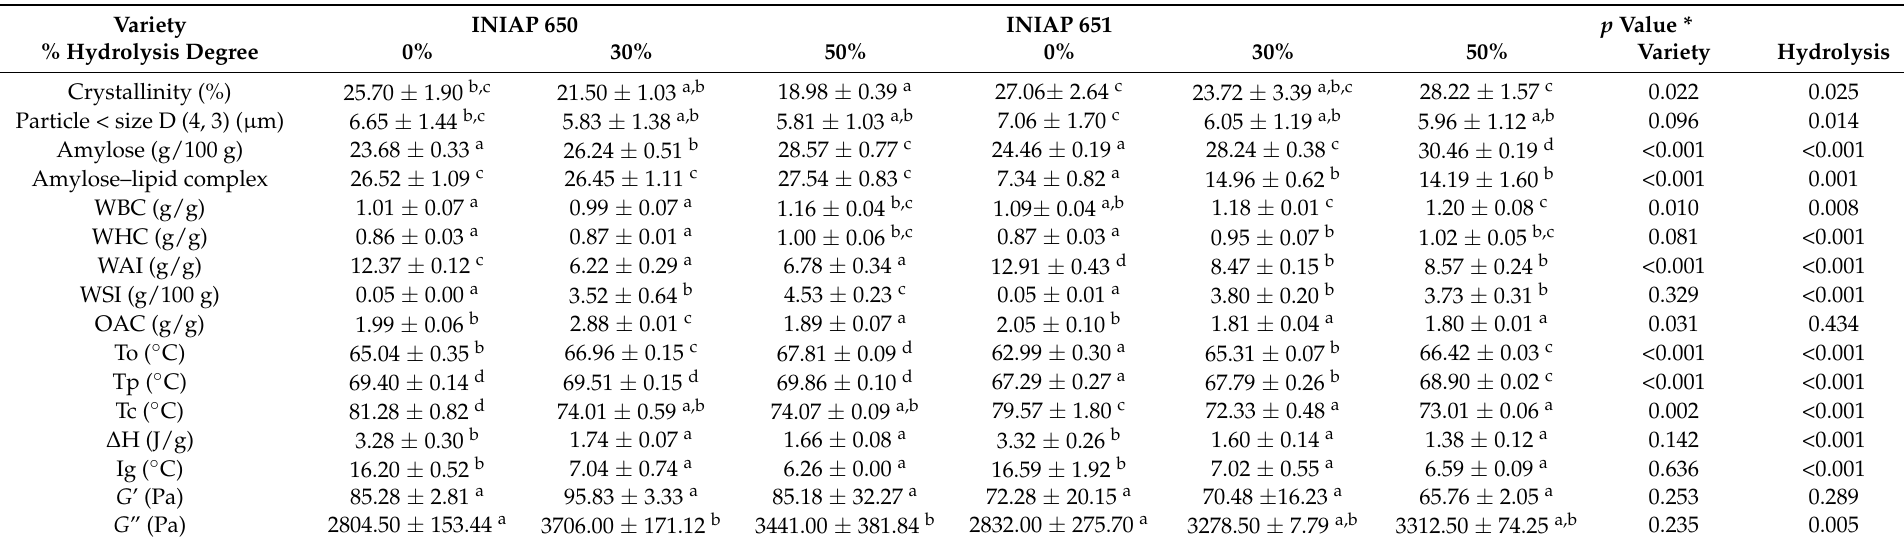
Table 1. Structural and physicochemical properties of different cassava starch varieties and hydrolysis